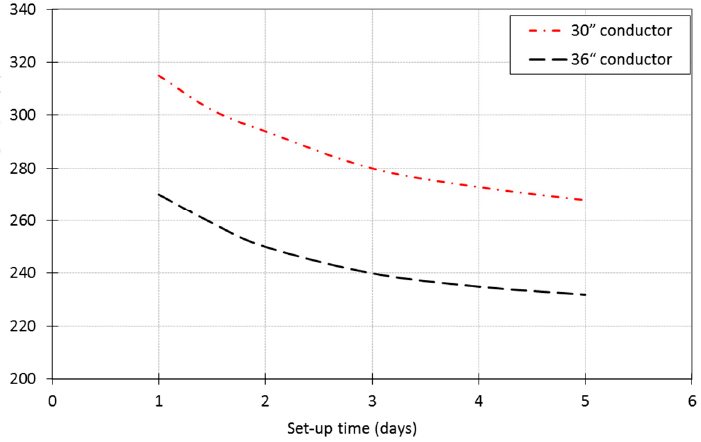
Figure 11. The relationship curve between set-up period and surface conductor setting depth (20 ″ casing @500 m, landed load is 424 kips).